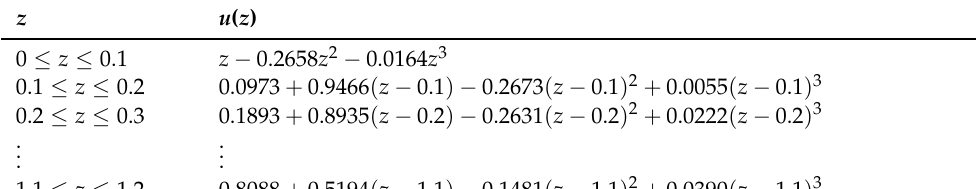
Table 2. Piecewise convergent approximate solution for u ( z ) with Ω m = 0.311, ω 0 = − 0.937, and ω 1 = 0.064.